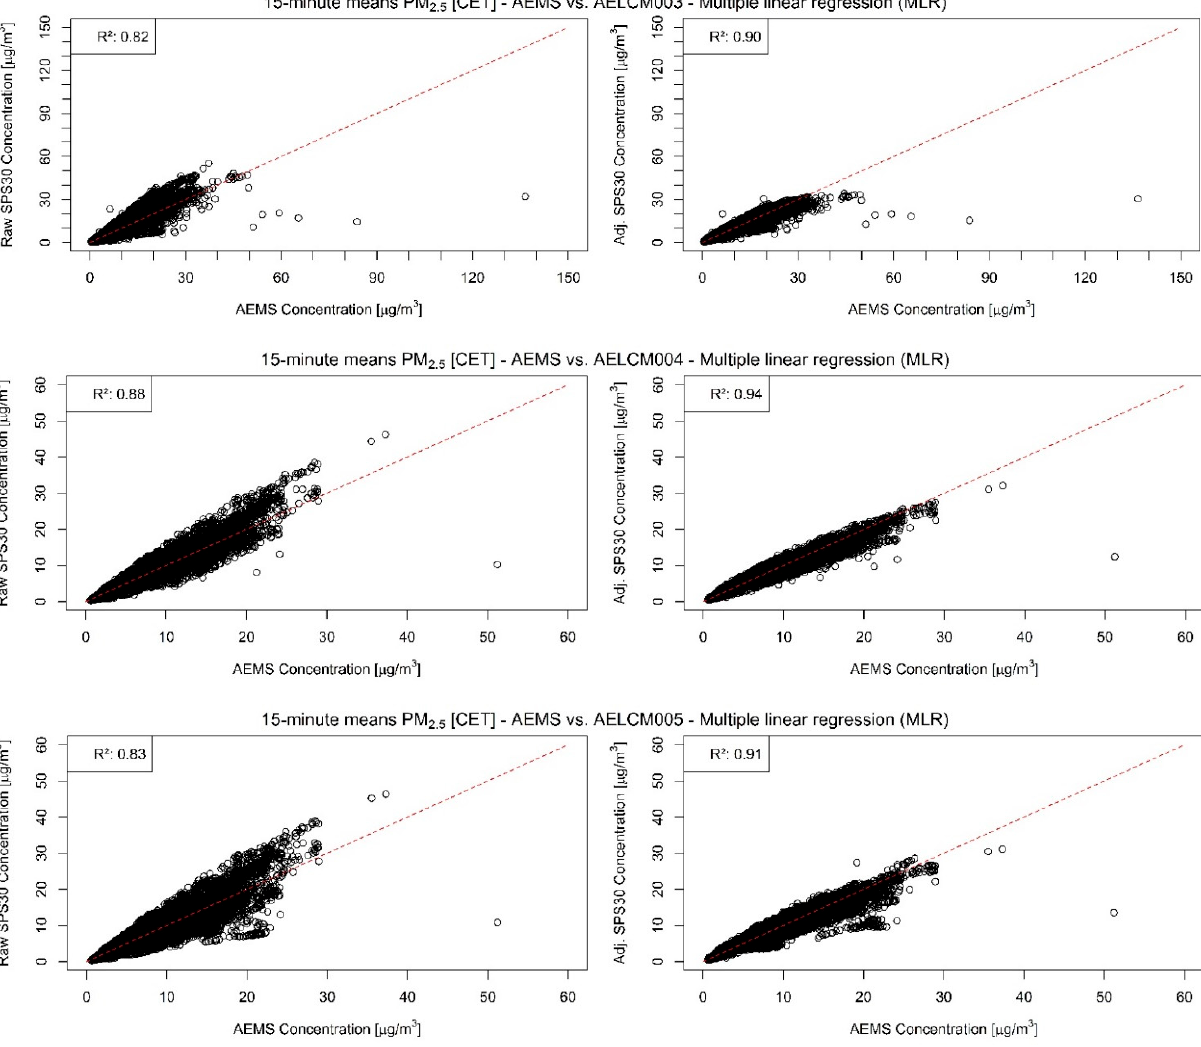
Figure 4. Raw ( left ) and model-adjusted ( right ) 15 min concentration means of different deployed SPS30 vs. 15 min concentration means of reference measurements given by the AEMS for PM2.5 in µ g/m 3 : ( Top ) SPS30 deployed in AELCM003; ( Middle ) SPS30 deployed in AELCM004; and ( Bottom ) SPS30 deployed in AELCM005. Multiple linear regression is used for adjusting the raw LCS data. The slightly worse agreement of model-adjusted PM2.5 values with the reference measurements is also reflected in the higher errors. These discrepancies expressed